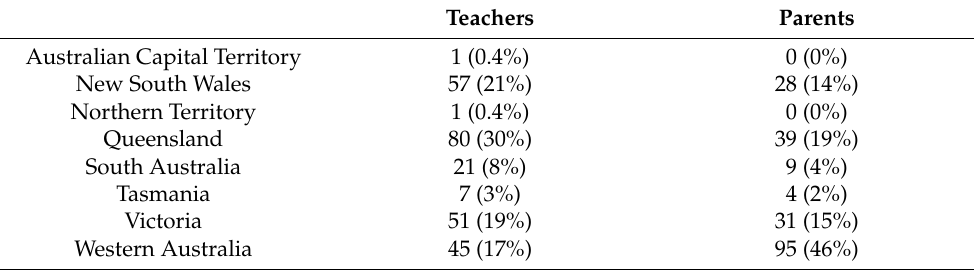
Table 1. Frequency statistics for the Australian state/territory of residence of participants.